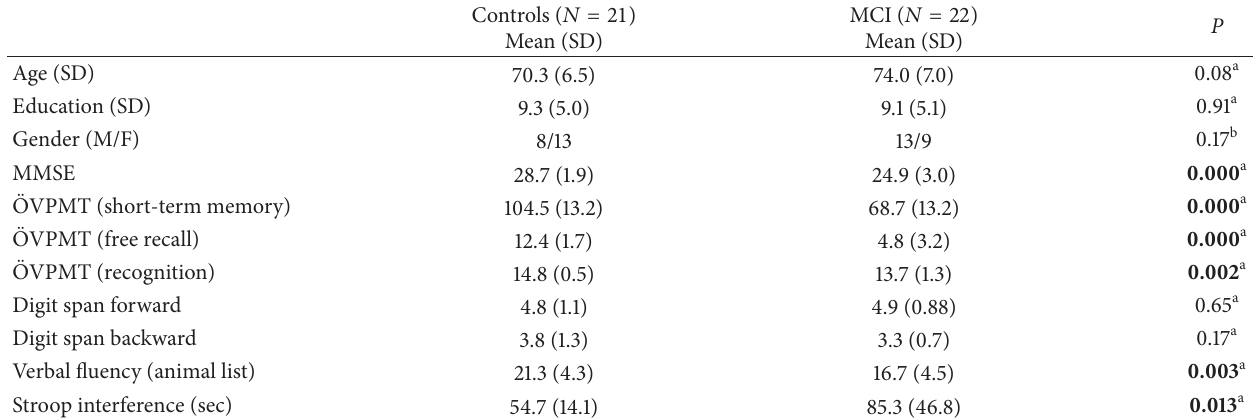
Table 1: Demographic and neuropsychological details of study